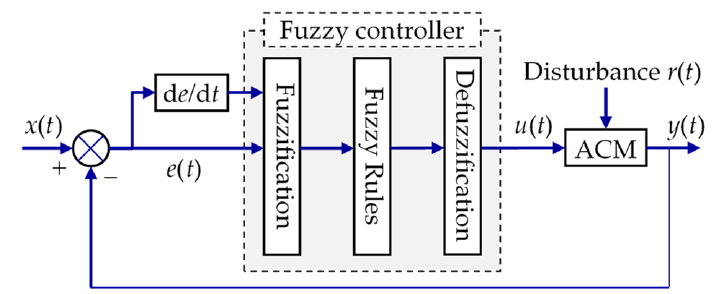
Figure 7. Fuzzy control block diagram.